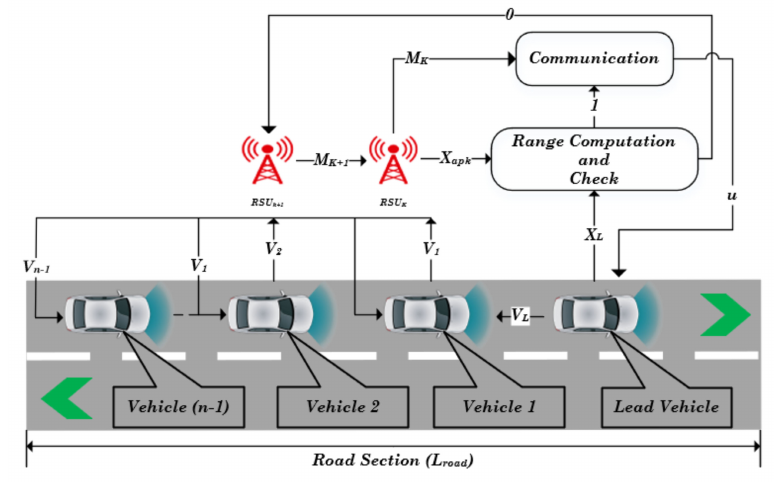
Figure 6. V2X oriented Intelligent Driver Control